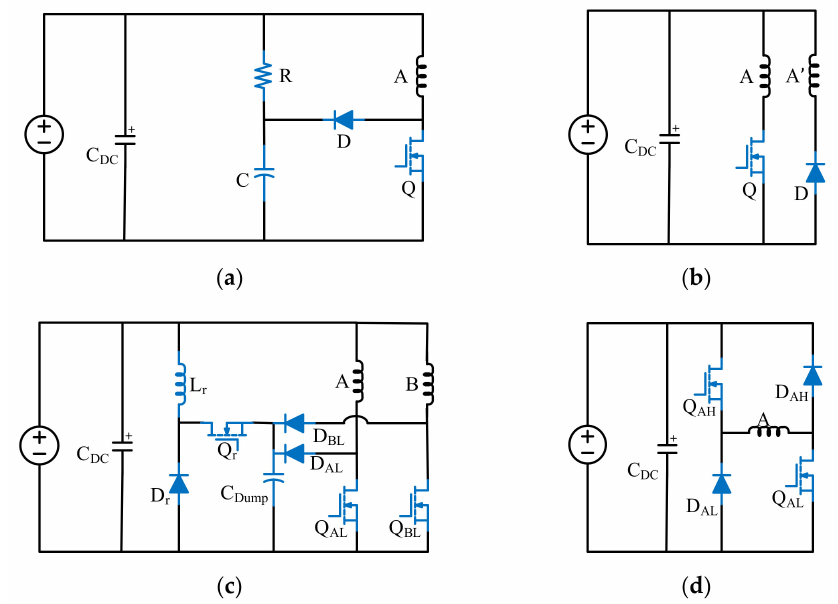
Figure 13. SR converters: ( a ) R-dump dissipative converter; ( b ) Bifilar magnetic converter; ( c ) C- dump resonant converter; ( d ) Asymmetric single capacitor type capacitive converter.